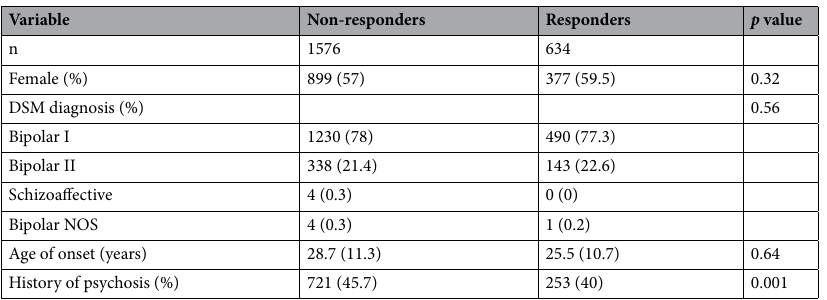
Table 2. Demographic statistics. Categorical variables are presented as counts and percentages, whereas continuous variables are presented as means and standard deviations (SD). History of psychosis refers to the occurrence of psychotic symptoms at any point during the course of illness. Abbreviations: age at onset (AAO), not otherwise specified